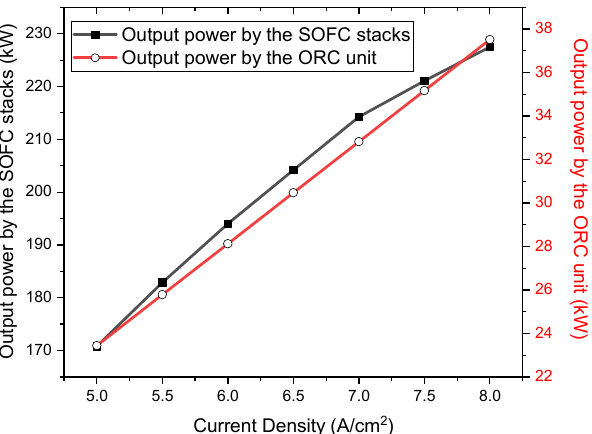
Figure 3. The changes in the output powers of the SOFC stacks and the ORC unit by the variation in the SOFC’s current density.